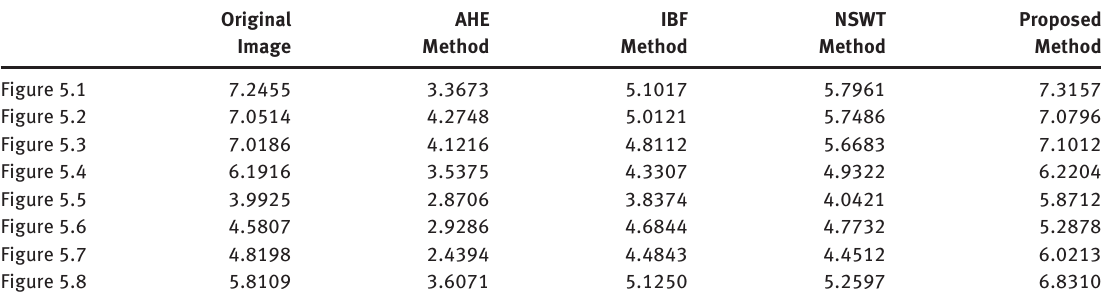
Table 1. Comparison of IE.